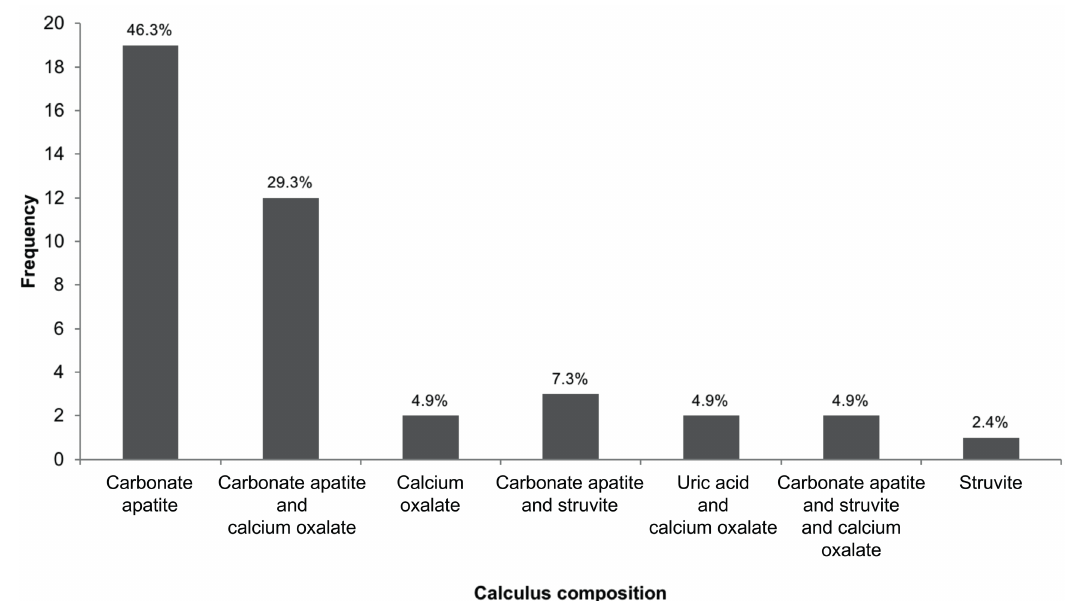
Figure 1 - Frequency of calculus